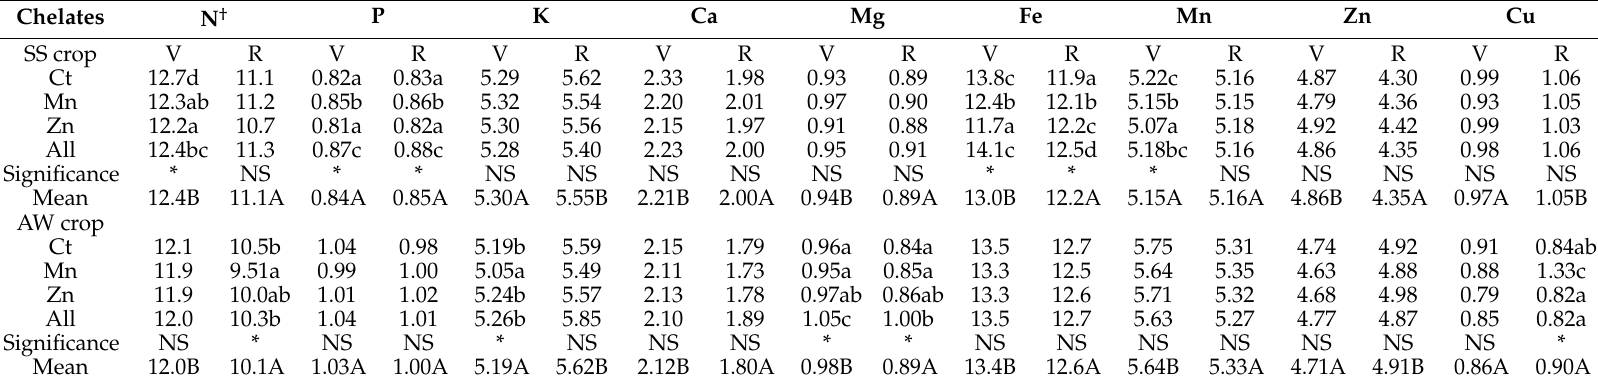
Table 2. Macronutrient N, P, K, Ca and Mg (mmol L − 1 ) and micronutrient Fe, Mn, Zn and Cu ( µ mol L − 1 ) uptake concentrations (UCs) in di ff erent growth stages (Vegetative-V and Reproductive-R) of NFT-grown common bean plants submitted to nutrient solution (NS) treatments, di ff ering in the supplied forms (chelates or inorganic) of manganese (Mn) and zinc (Zn) in two cropping seasons (spring-summer, SS crop; autumn-winter, AW crop). The treatments (NS) were: «Ct», NS with inorganic Mn and Zn; «Mn», NS with chelated Mn; «Zn», NS with chelated Zn; «All», NS with chelated Mn and